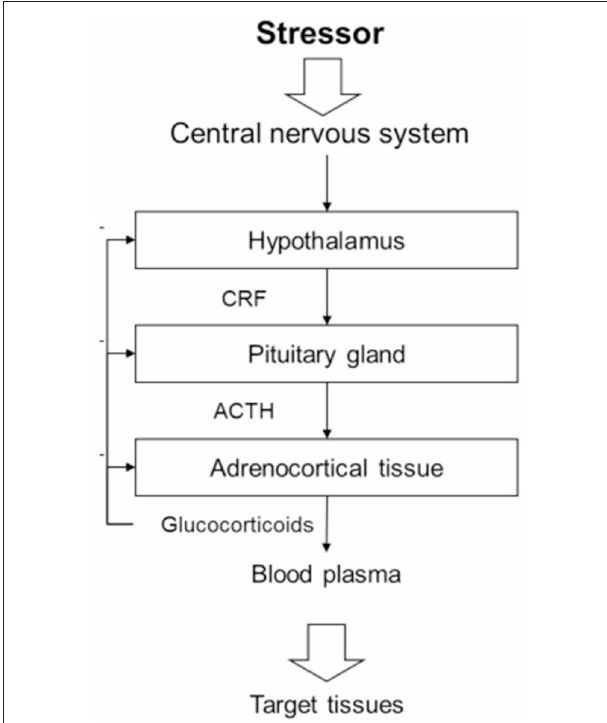
FIGURE 1 | Schematic drawing of the hypothalamic pituitary adrenocortical axis. The primary physiological stress response is partly mediated by the hypothalamic–pituitary–adrenocortical (HPA) axis in mammals. A stressor activates the central nervous system and the hypothalamus then releases corticotropin releasing factor (CRF) unto the pituitary gland. The pituitary gland will in its turn release adrenocorticotropic hormone (ACTH), which induces glucocorticoid synthesis and release from the adrenal tissue into the blood. The glucocorticoids will then affect target tissues throughout the body mainly to increase energy availability and inhibit processes not necessary for the immediate survival. Each step of the HPA axis is self-regulated by an array of feedback